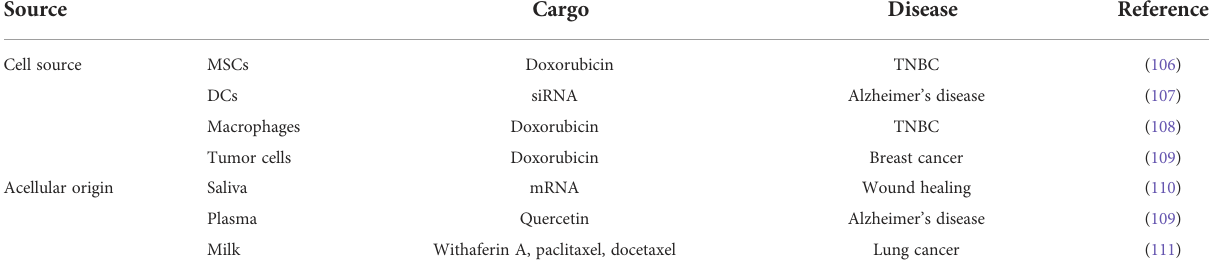
TABLE 3 sEVs derived from different types of origins served as drug delivery system.